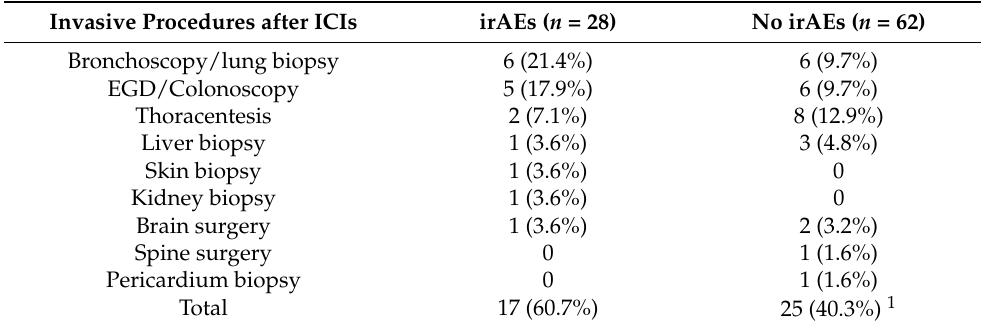
Figure 2. Significant clinical and molecular features with irAEs. ( A ) Association of irAEs with gender, ( B ) smoking status, ( C ) genomic alterations in LRP1B , and ( D ) MLL3 . * Fisher’s exact test by GraphPad. Table 3. Invasive procedures after ICIs.